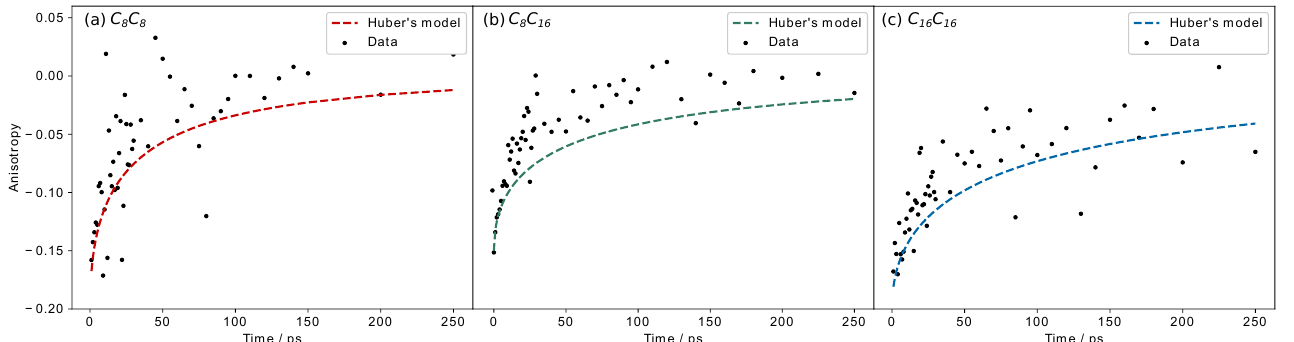
Figure 5. The decay of the anisotropy in the dichloroalkoxy neat films, plotted against the curves predicted by the Huber